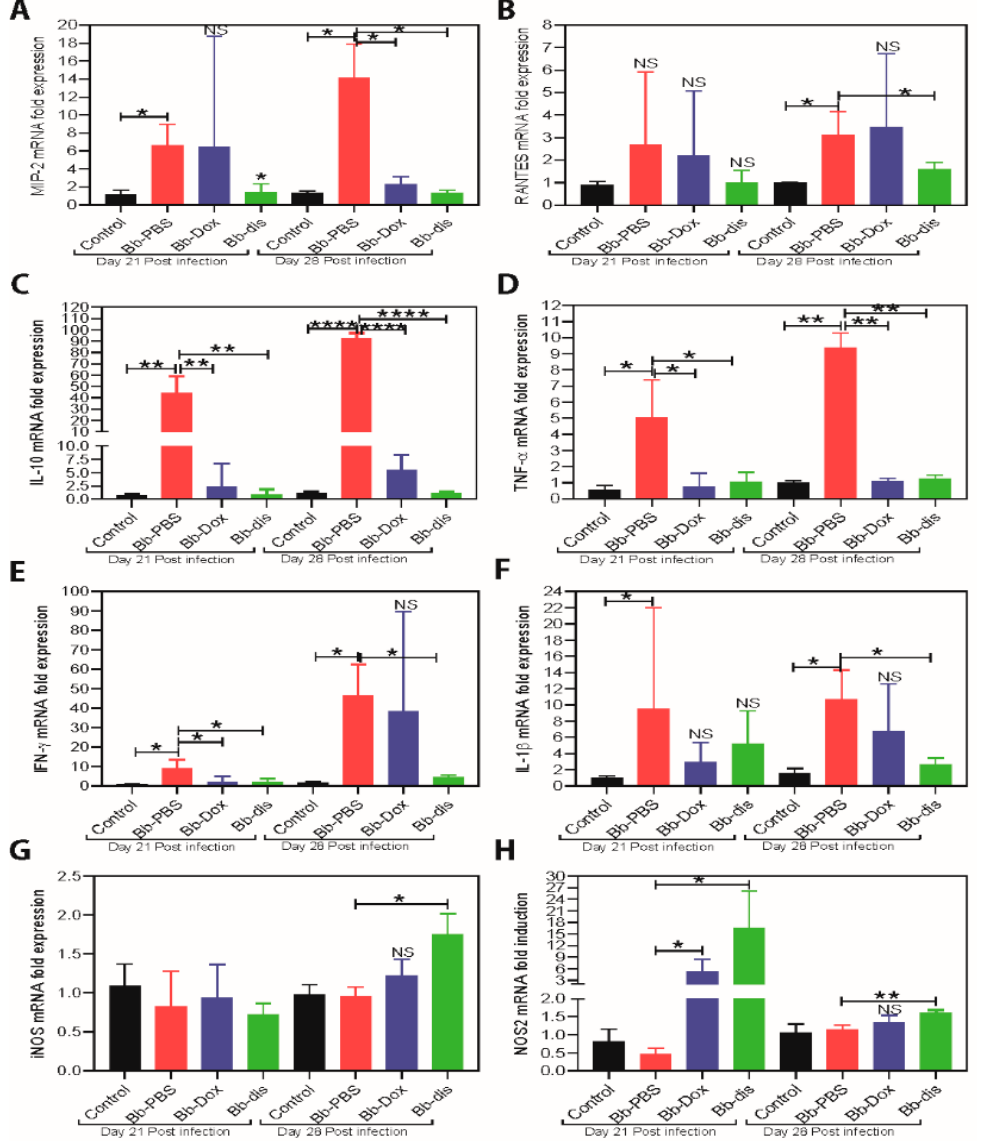
Figure 4. Measurement of immunomodulators in the hearts of C3H/HeN mice with or without antibiotics treatment by RT-PCR. ( A – H ) RT-PCR of pro-inflammatory transcripts (MIP-2, RANTES, TNF- α , IFN- γ and IL-1 β ) and important protective immunoregulatory transcripts (IL-10, iNOS and NOS-2) in the heart. Statistics by unpaired t-test with Welch’s correction between control versus infected and also between drug-treated group versus infected group. * p < 0.05, ** p < 0.01, **** p < 0.0001. NS means not significant.